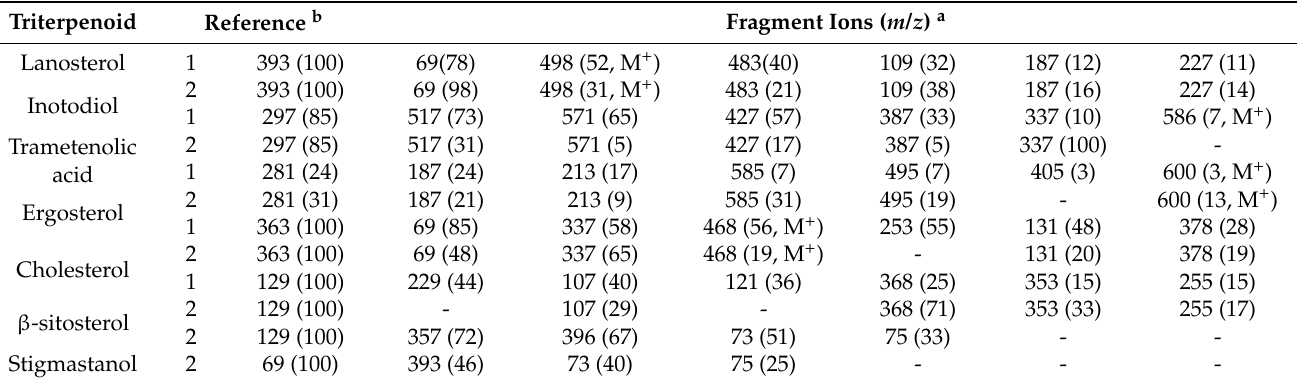
Table 2. GC-MS spectrometric data of the TMS ether of the main triterpenoids.